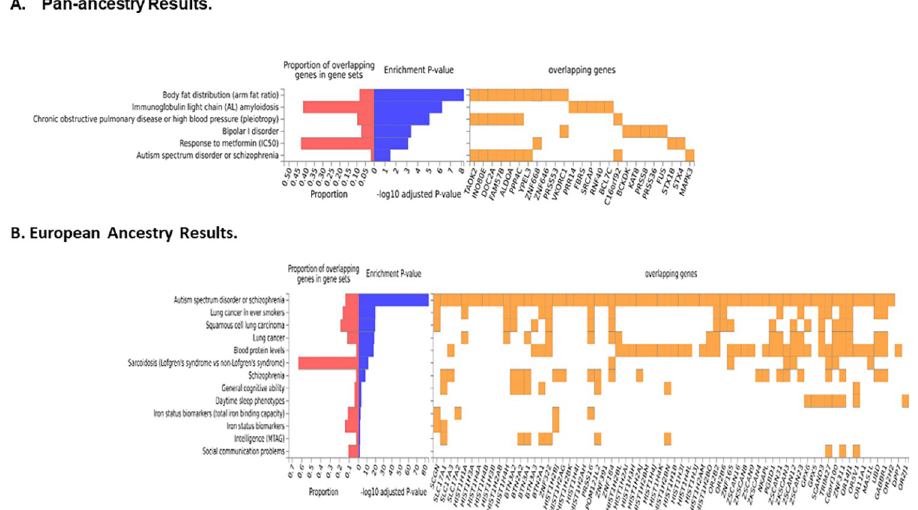
Fig 3. Enrichment of GWAS Catalog Terms. A. Pan-ancestry Results. B. European Ancestry Results.